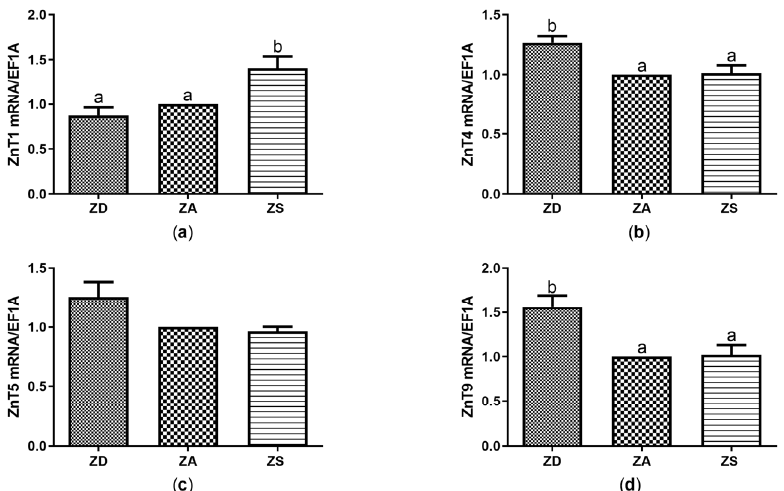
Figure 3. SF cells were cultured in CHELEX-treated medium, zinc adequate (ZA) medium or medium supplemented with zinc (50 µ M) for 7 days. Afterwards mRNA was isolated, used for measuring expression of ZnT1 ( a ), ZnT4 ( b ), ZnT5 ( c ) and ZnT9 ( d ) mRNA expression and normalized to EF1A mRNA. Mean values + SEM of n = 7 independent experiments are shown. Significantly different data sets as determined by one-way Anova and Tukey’s post hoc test do not share the same letters ( p <